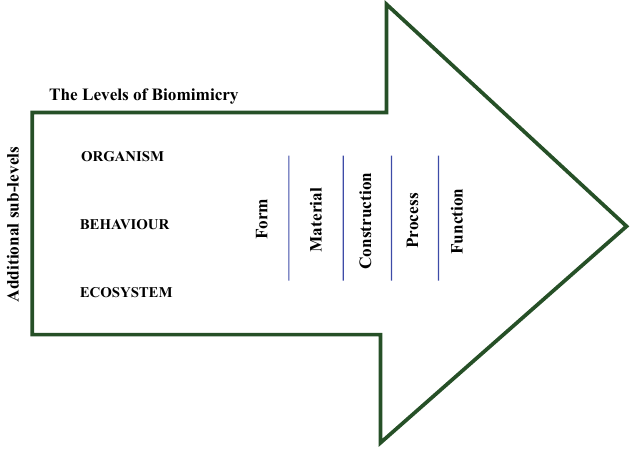
Figure 2. Three principal levels and five sub-levels of biomimicry for architectural design.